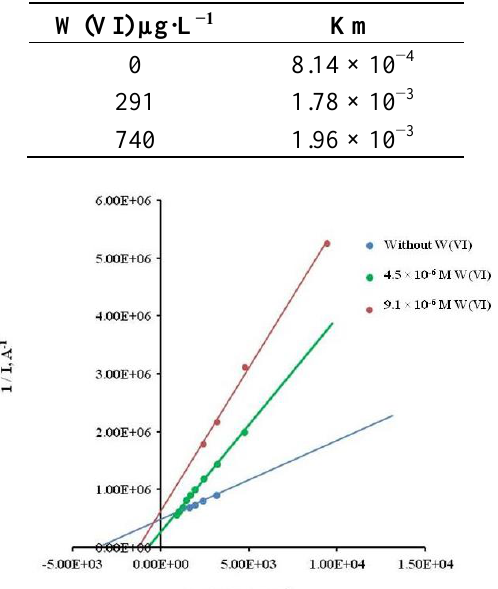
Table 3. Michaelis-Menten apparent constant values at different W(VI) concentration.